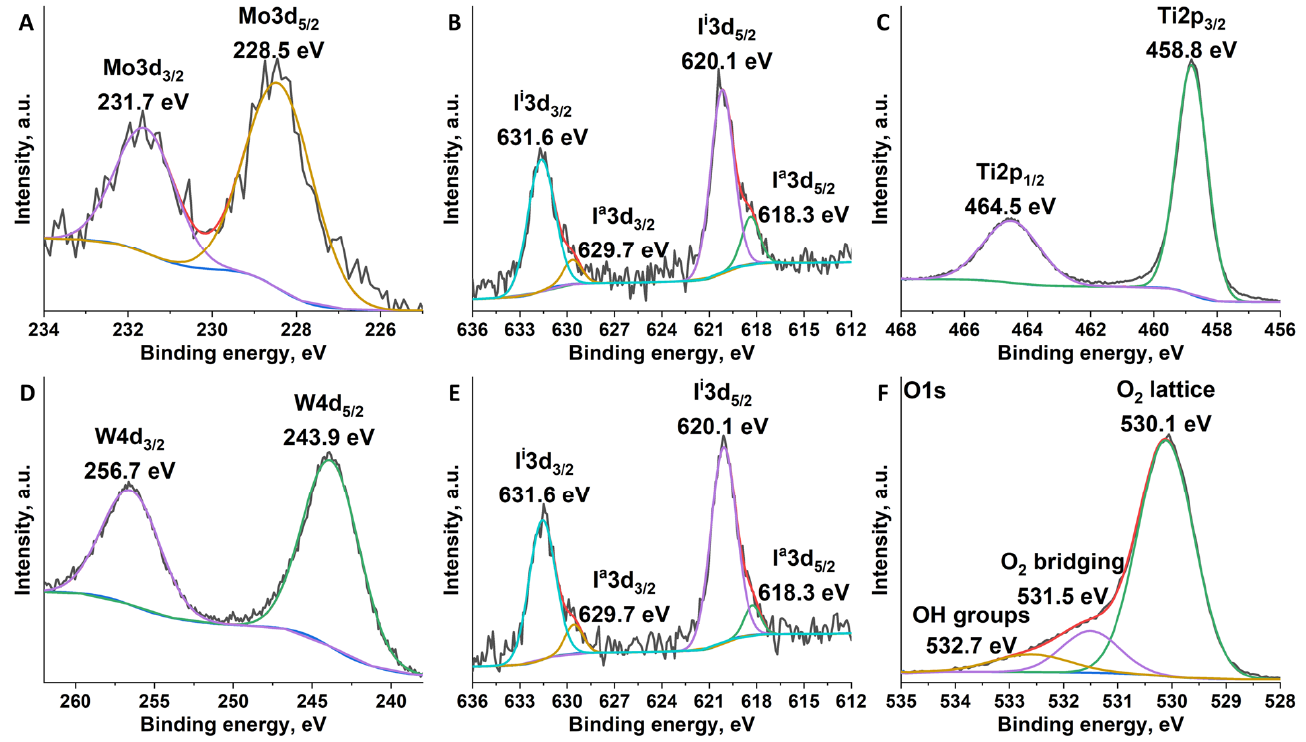
Figure 2. High-resolution XPS spectra of Mo3d ( A ), I3d (in 1 0.1 @TiO 2 ) ( B ), Ti2p (in 1 0.1 @TiO 2 ) ( C ), W4d ( D ), I3d (in 2 0.1 @TiO 2 ) ( E ), and O1s (in 1 0.1 @TiO 2 ) ( F ) core levels in n 0.1 @TiO 2 .